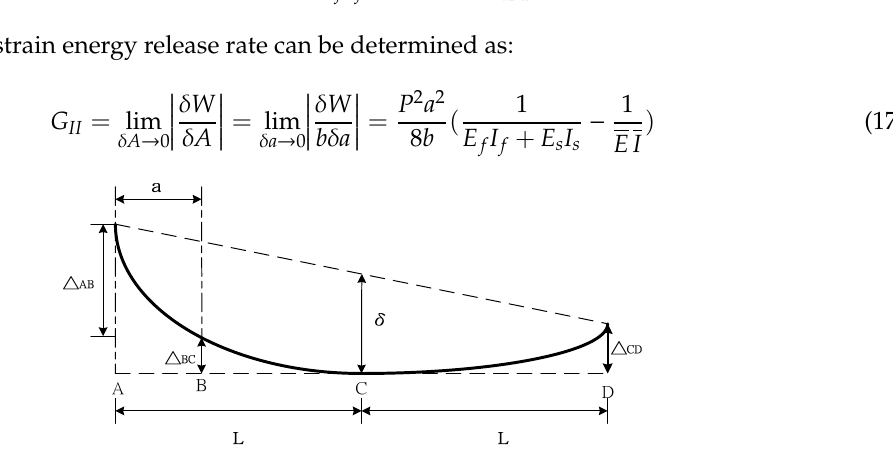
Figure 3. Schematic diagram of the deflection of the ENF specimen subjected to three-point bending.